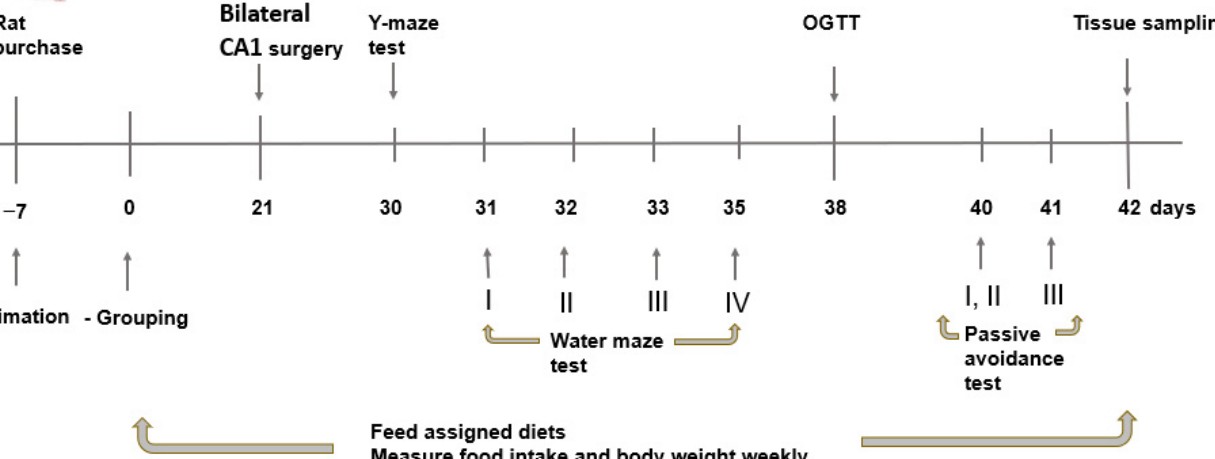
Figure 1. Experimental design . After grouping the rats, they were fed a high-fat diet containing dextrin (AD-Con), fucoidan with high molecular weight (MW; AD-F-H), fucoidan with low-MW (AD-F-L), λ -carrageenan with high MW (AD-C-H), or λ -carrageenan with low MW weight (AD-C- L). The rats in the Normal-Con had hippocampal saline infusion to have no amyloid- β deposition and were fed a high-fat diet (Normal-Con). At 21 days from feeding the assigned diet, a stainless- steel cannula was implanted in the bilateral CA1 subregions of the hippocampus, and A β (25–35) fragment was infused into the hippocampus for 28 days. The assigned diet was provided until euthanizing of the rats. OGTT, oral glucose tolerance test.